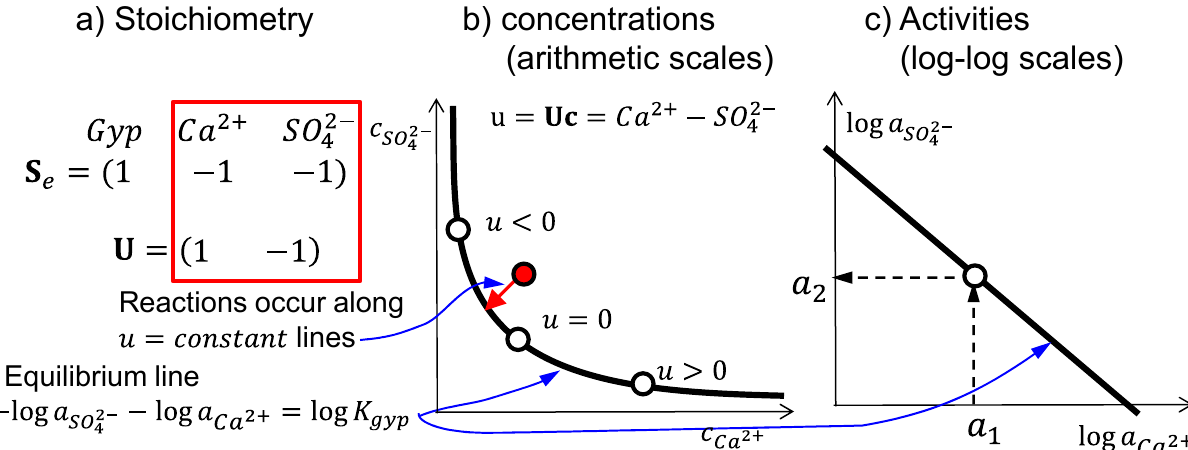
Figure 4. Example of a gypsum equilibrium chemical system with three species (gypsum, Ca 2 + , and SO 2 − ). S e ( a ) consists of only one row. If gypsum activity is assumed constant, the concentration space, S e , and U , are reduced to 2 dimensions (red square). Equilibrium restricts c to 1 dimension, both in the c ( b ), u and log a ( c ), in log-log scale to highlight linearity in log activity